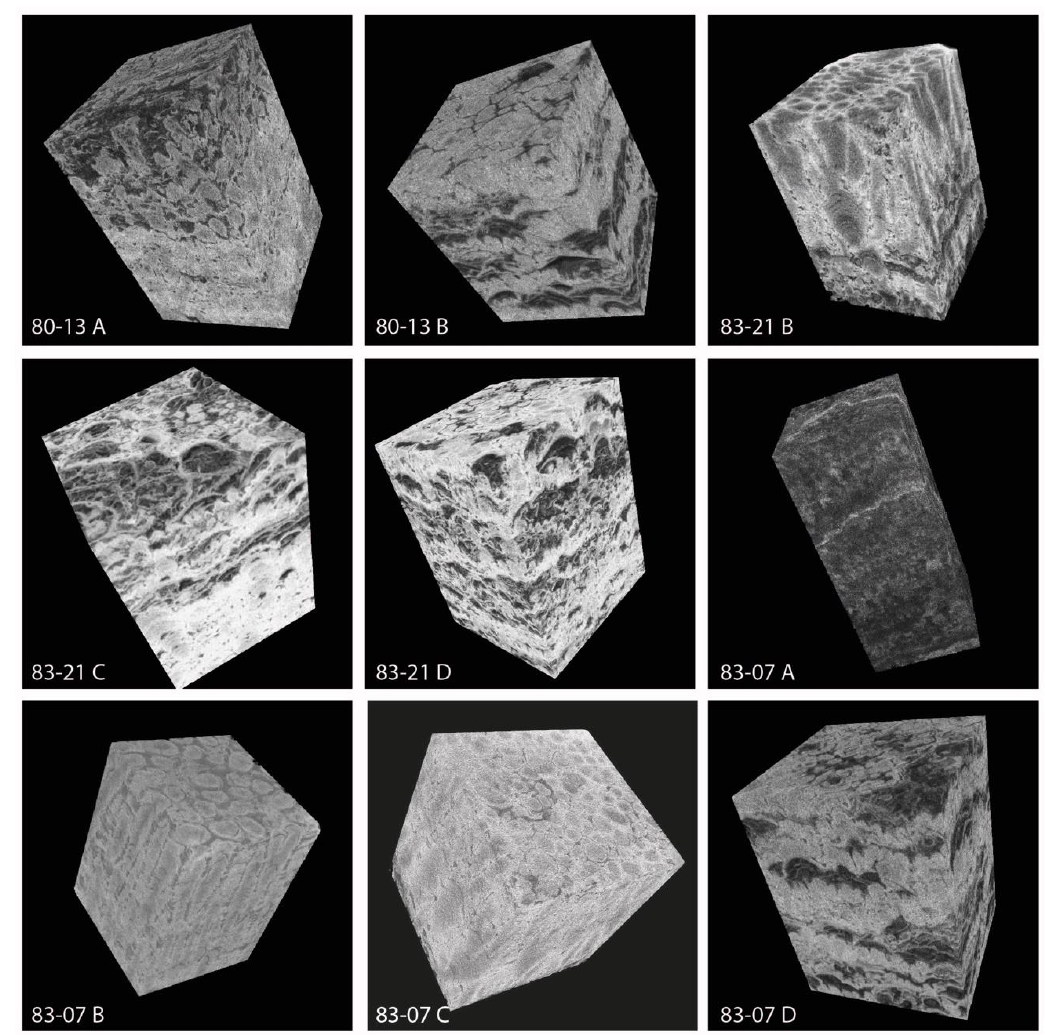
Figure 3. Block diagrams from all the samples analyzed, excluding 83-21 A, which was purely drilled into carbonate basement. The block diagrams are all between 3 and 4 mm across and show good examples of pillar (83-07 B, 83-07 C, 83-21 B) and cuspate (80-13 B, 83-21 D, 83-07 D) texture, as well as some samples with mixtures of both textures. The greyscale is individual to each sample and was set to maximize visible contrast in the samples themselves.